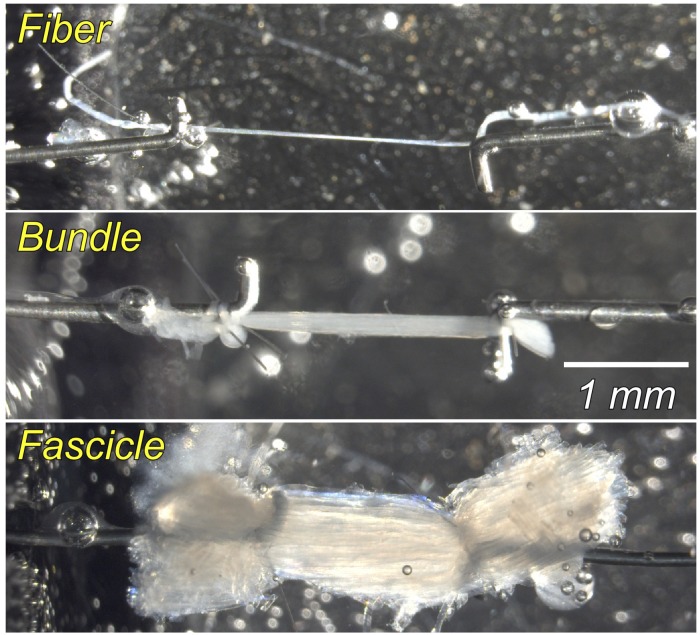
Photomicrograph of samples at the single fiber, fiber bundle (approximately 20 fibers), and fascicle (∼300 fibers, defined by natural ECM divisions) scale. Each sample (1.5–3.0 mm in length) was secured using suture to a force transducer on one end and a titanium wire rigidly attached to a rotational bearing on the other end. Each stretch was held for 3 min to permit stress-relaxation before measuring passive tension. See text for details.